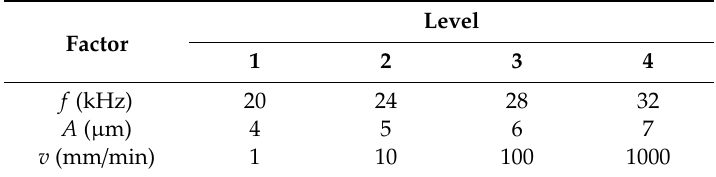
Table 7. The ultrasonic vibration tensile simulation experimental